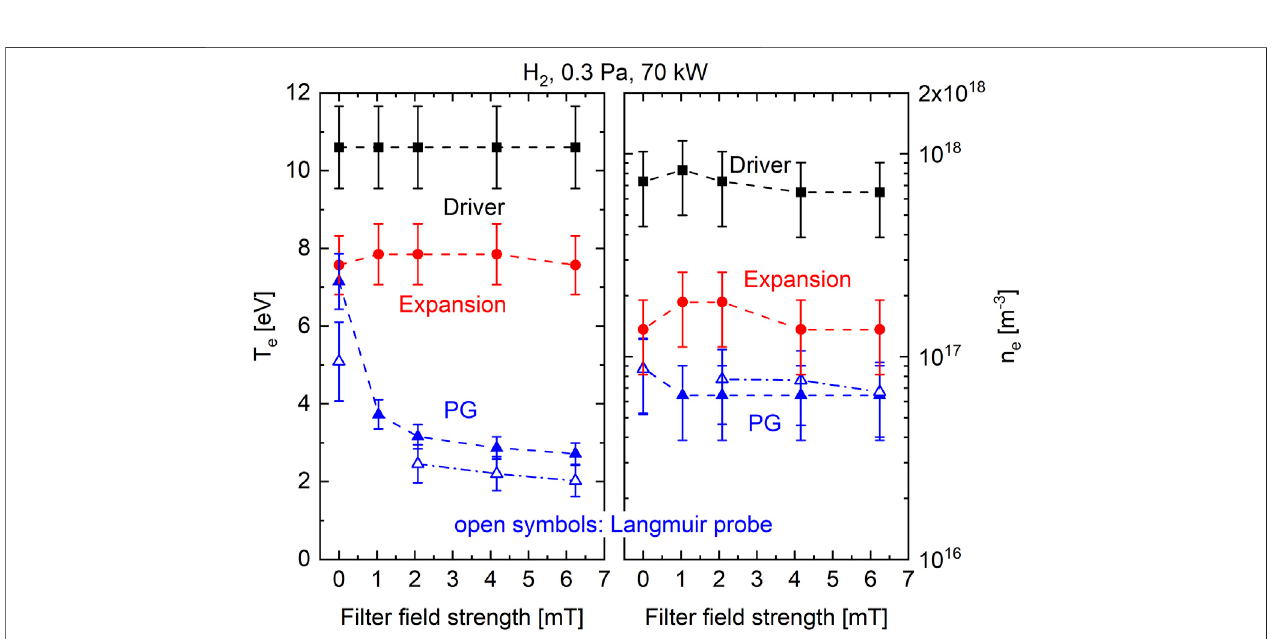
FIGURE 3 | Electron temperature and density obtained for varying fi lter fi eld strengths from OES at different lines of sight. For comparison, the values determined from Langmuir probe measurements at a distance of 2.6 cm upstream of the extraction system are also included (PG, open symbols). It should be noted that the fi lter fi eld strength values are given for a position of 2 cm away from the PG surface and both vertically and horizontally centered.